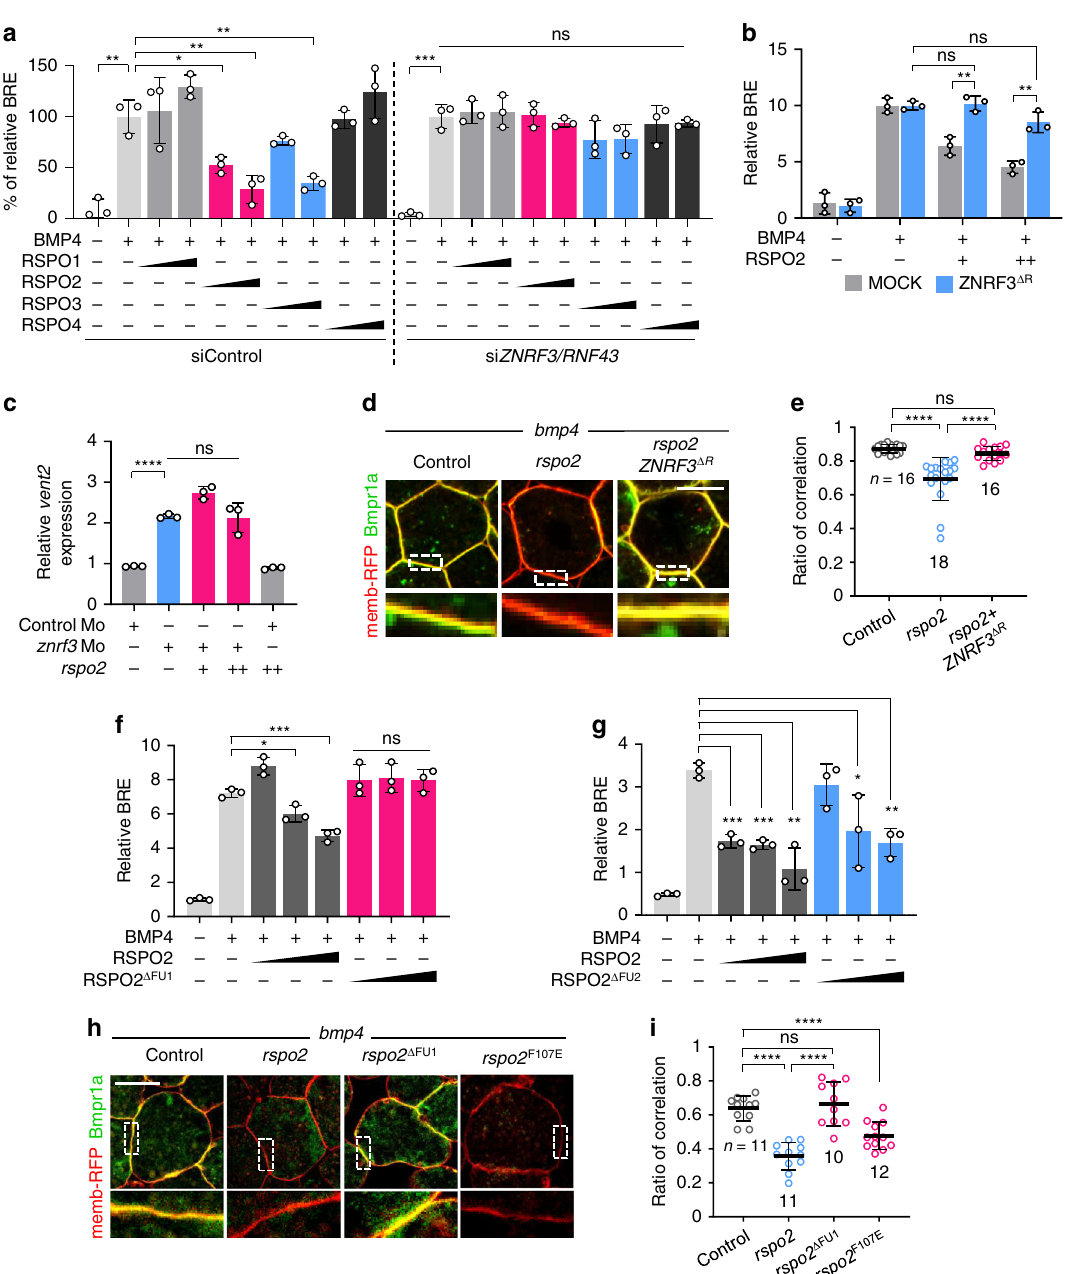
Fig. 7 RSPO2 requires ZNRF3 to antagonize BMP4-BMPR1A signaling. a BRE reporter assay in HEPG2 cells. Cells were transfected with siControl or si ZNRF3 /si RNF43 , and BMP4 with or without RSPO1-4 were added overnight as indicated. Normalized BRE activity upon BMP4 without RSPO2 stimulation was set to 100%. n = 3 biologically independent samples. b BRE reporter assay in HEPG2 cells upon ZNRF3 Δ R transfection, with or without overnight BMP4 and RSPO2 treatment as indicated. n = 3 biologically independent samples. c BMP-reporter ( vent2 ) assay in Xenopus laevis St.15 neurulae. Embryos were injected animally with reporter plasmids and the indicated Mo with or without rspo2 mRNA at 4-cell stage. Normalized vent2 activity of control Mo injected embryos with reporter plasmids was set to 1. n = 3 biologically independent samples. d Immuno fl uorescence microscopy (IF) in Xenopus laevis animal cap explants for Bmpr1a (green) and the plasma membrane (red) from embryos injected with mRNA as indicated, with a representative cell (top) and magni fi cation (inset). Scale bar, 20 μ m. For scheme, see Fig. 6c. e Quanti fi cation of d . n = areas analyzed and data are displayed as mean ± SD. ns, not signi fi cant, **** P < 0.0001 from one-way ANOVA analysis. f – g BRE reporter assay in HEPG2 cells treated with BMP4 and RSPO2/RSPO2 Δ FU1 /RSPO2 Δ FU2 overnight as indicated. For domain structure of RSPO2 Δ FU1 /RSPO2 Δ FU2 , see Supplementary Fig. 8a. n = 3 biologically independent samples. h IF for Bmpr1a (green) and plasma membrane (red) in animal cap explants injected as indicated, with a representative cell (top) and magni fi cation (inset) showing the plasma membrane. Scale bar, 20 μ m. For domain structure of Xenopus Rspo2 mutants, see Supplementary Fig. 8d. i Quanti fi cation of h . n = areas analyzed and data are displayed as mean ± SD. ns, not signi fi cant, **** P < 0.0001 from one-way ANOVA analysis. All data are displayed as mean ± SD. The P values for reporter assays ( a – c , f , g ) were determined from two-tailed unpaired t -test. ns, not signi fi cant; * P < 0.05, ** P < 0.01, *** P < 0.001, **** P <